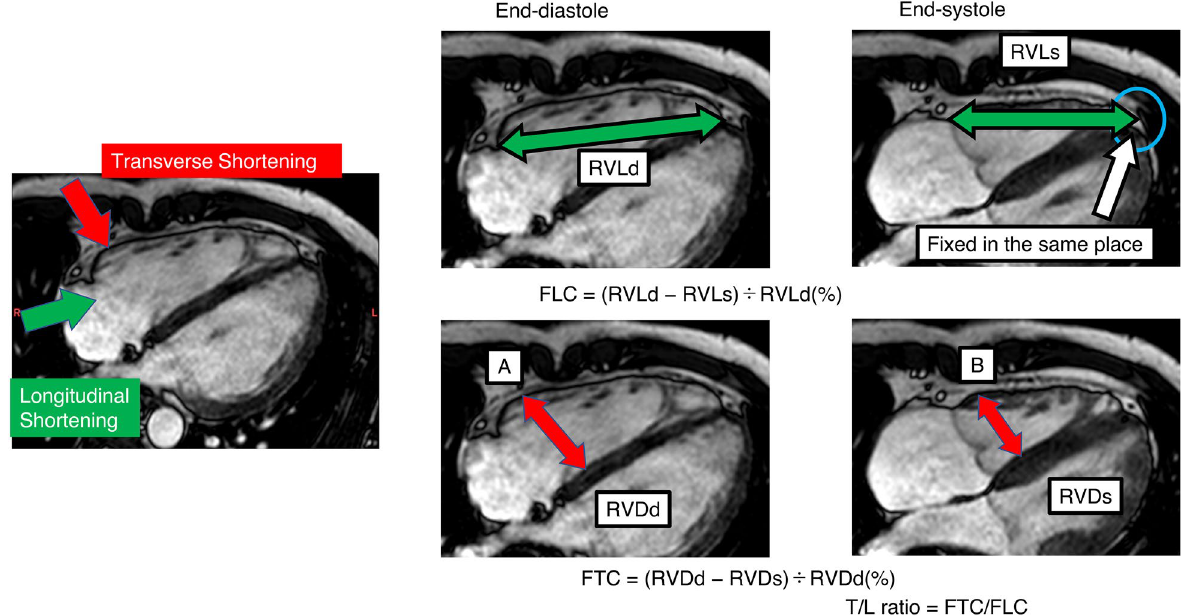
Figure 2. Measurement of fractional longitudinal change (FLC) and fractional transverse change (FTC). FLC = (RVLd − RVLs)/RVLd × 100(%), where RVLd is the RV length in end-diastole, and RVLs is the RV length in end-systole. RV length was defined as the distance from the RV apex to the attachment of the trigeminal valve in the RV free wall. We designated the location of the apex in end-systole as the same as that in end-diastole to address ostensible migration of the apex, which may cause overestimation of longitudinal contraction. We considered FLC to represent the parameter of longitudinal contraction. FTC = (RVDd − RVDs)/RVDd × 100(%), where RVDd is the RV diameter at end-diastole, and RVDs is the RV diameter at end-systole. The RV diameter was defined as the maximum distance between the septum and the RV wall, parallel to the annulus of